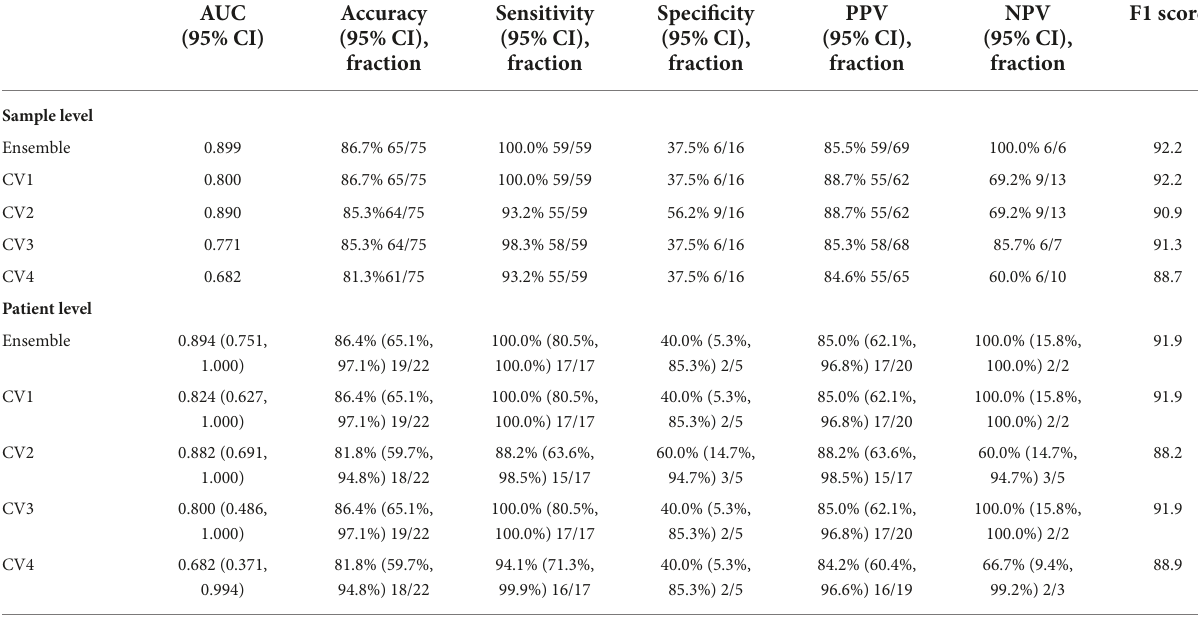
TABLE 3 Model performance metrics at sample and patient levels at the 0.5